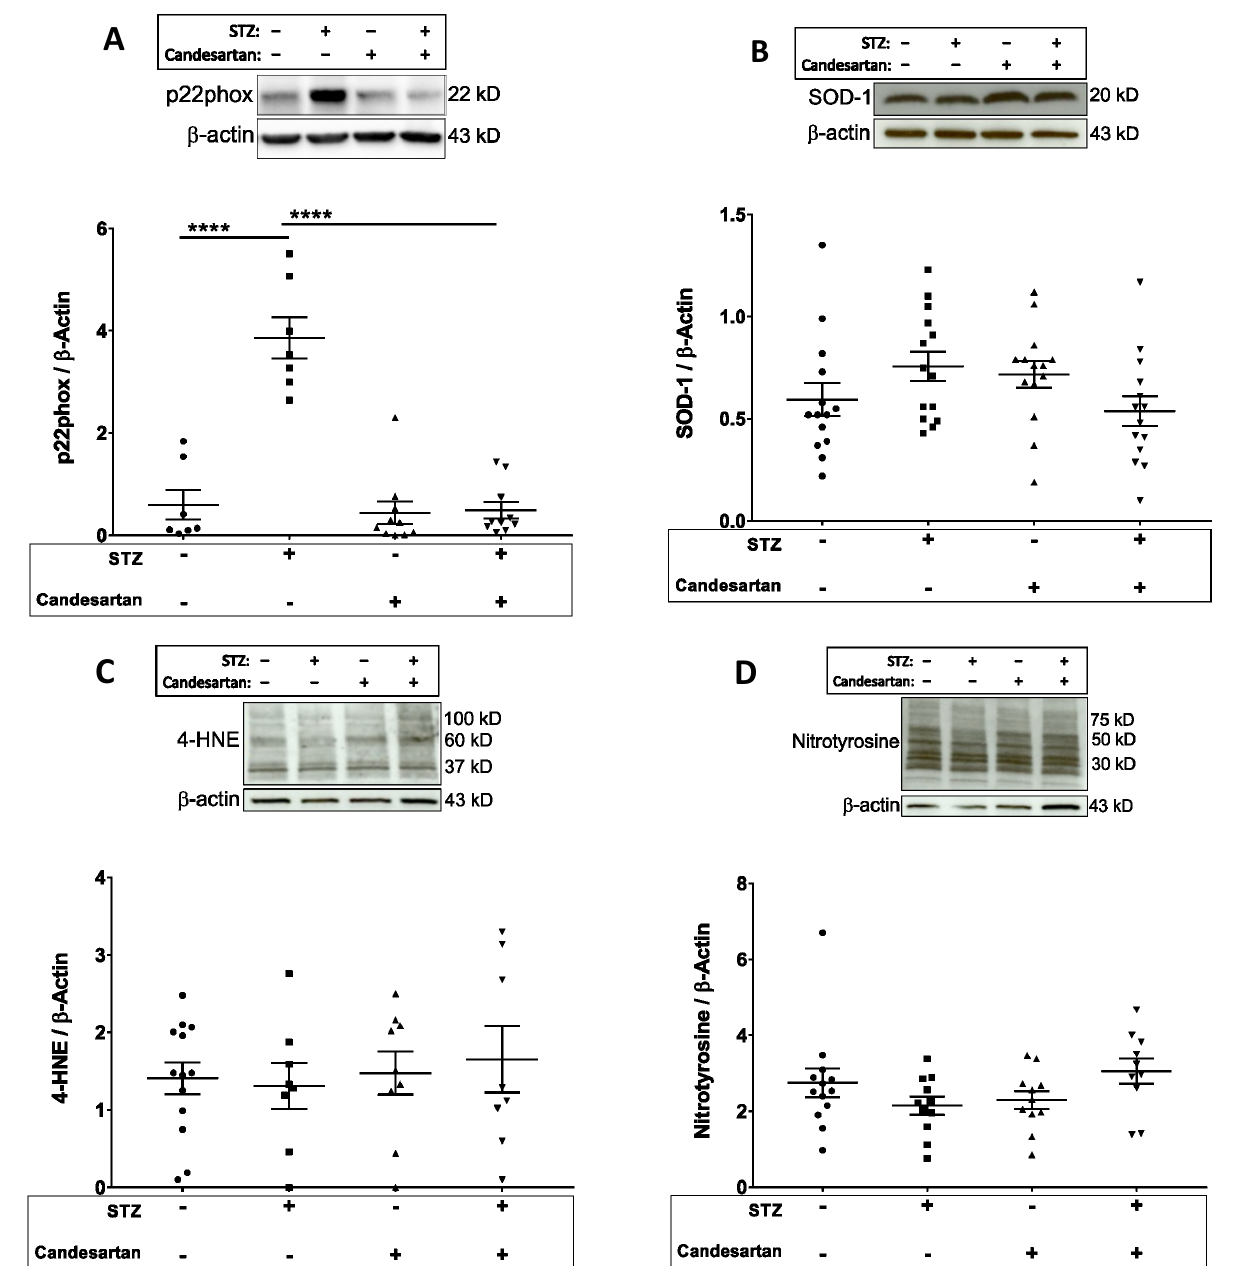
Figure 5. Retinal tissue protein levels (Western blot data; normalized to β-actin) of ( A ) the p22phox subunit of NADPH oxidase, ( B ) SOD-1, ( C ) 4-HNE, and ( D ) nitrotyrosine in the four groups of rats: untreated non-diabetic controls, untreated STZ, candesartan-treated non-diabetic controls, and candesartan-treated STZ. A significant increase ( p < 0.05) in p22phox was observed in the diabetic retina, which was attenuated with candesartan treatment; however, no statistical differences in SOD-1, 4-HNE, or nitrotyrosine were found between groups. N = 9–14 per group, **** p < 0.0001.